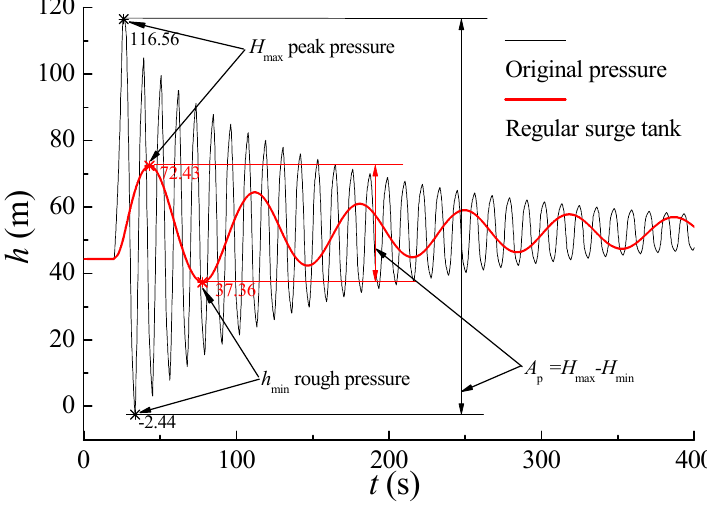
Figure 7. Transient pressure induced by a valve close.